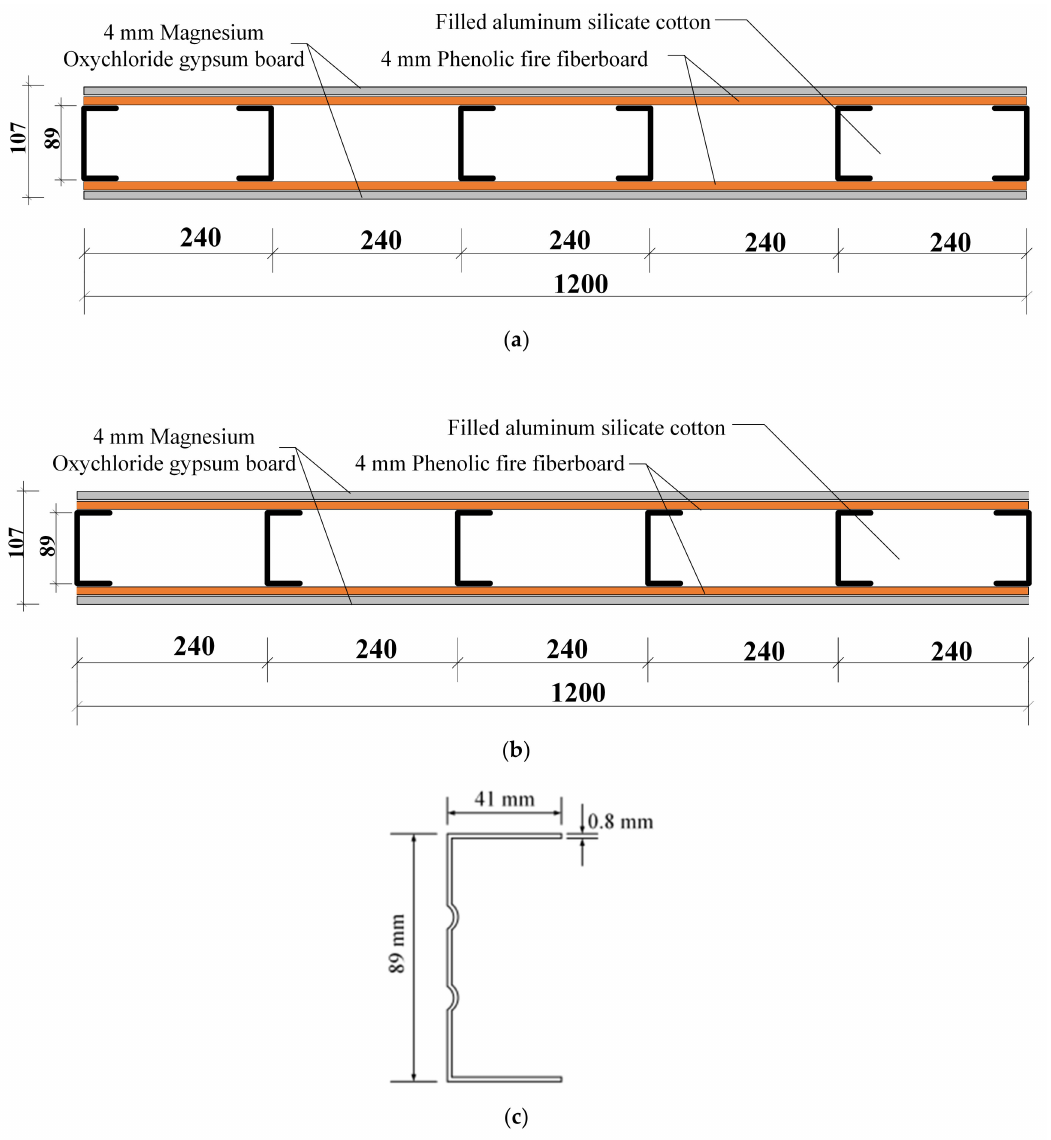
Figure 1. LSF walls section and stud section. ( a ) Type- Ⅰ walls section structure (symmetrical ar- rangement of light-gauge steel studs). ( b ) Type-II walls section structure (asymmetric arrangement of light-gauge steel studs). ( c ) Cross-section of light-gauge steel stud.